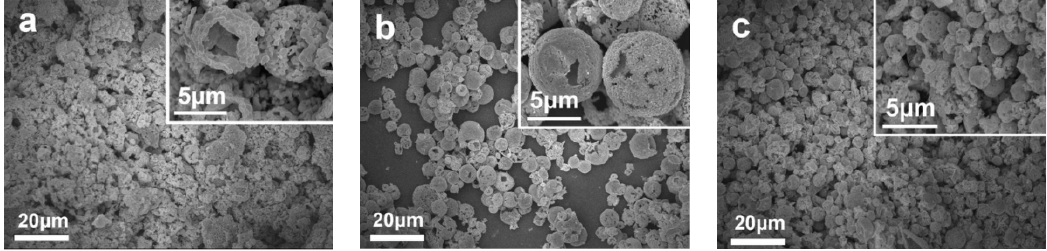
Figure 15. The SEM patterns of NiMn 2 O 4 with different dripping rate. ( a ) NiMn 2 O 4 (1 s), ( b ) NiMn 2 O 4 (2 s) and ( c ) NiMn 2 O 4 (3 s) [60].